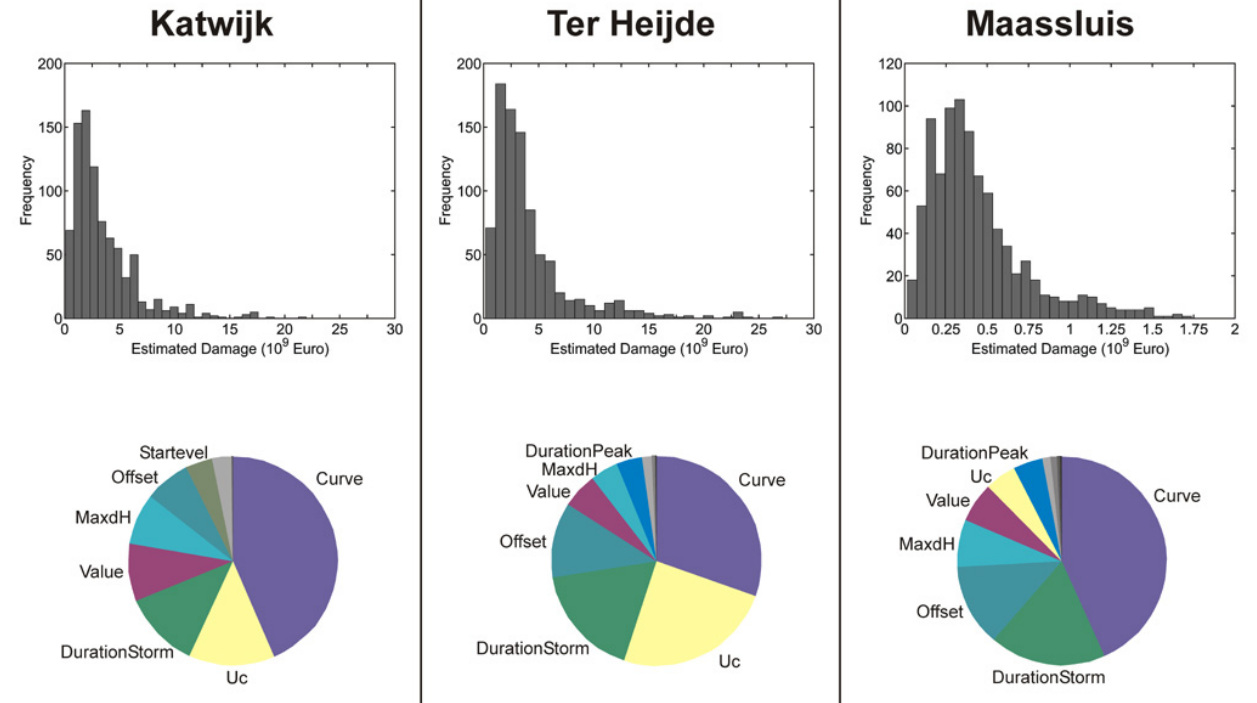
Fig. 6. Results of the uncertainty (histograms) and sensitivity (pie charts) analyses for the three locations considered in this study. The histograms show the variation in the damage estimates resulting from the Monte Carlo analyses. Note that a different scale is used for the x- and y-axis for Maassluis as compared to Ter Heijde and Katwijk. The pie charts represent the total variance of the output and indicate how much the uncertainty in each of the input parameter contributes to the variance of the damage